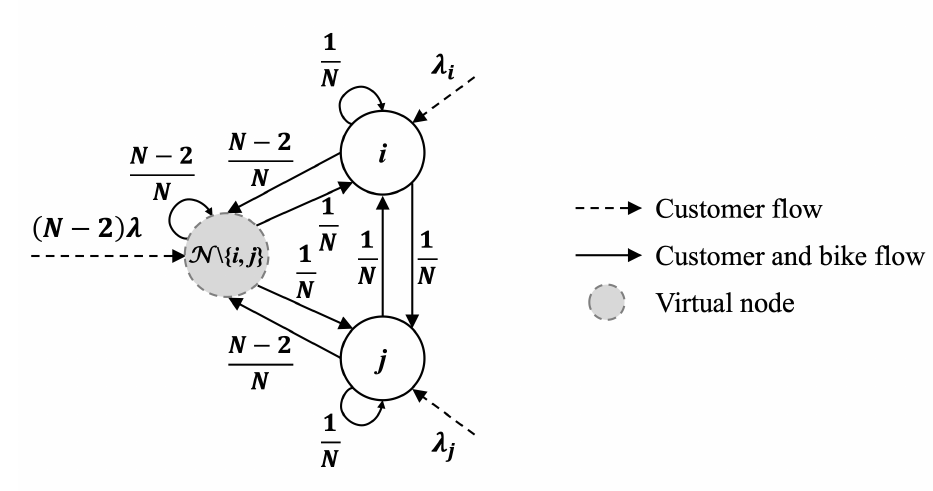
Figure 3. A reduced N -node network with the same probabilities and unequal